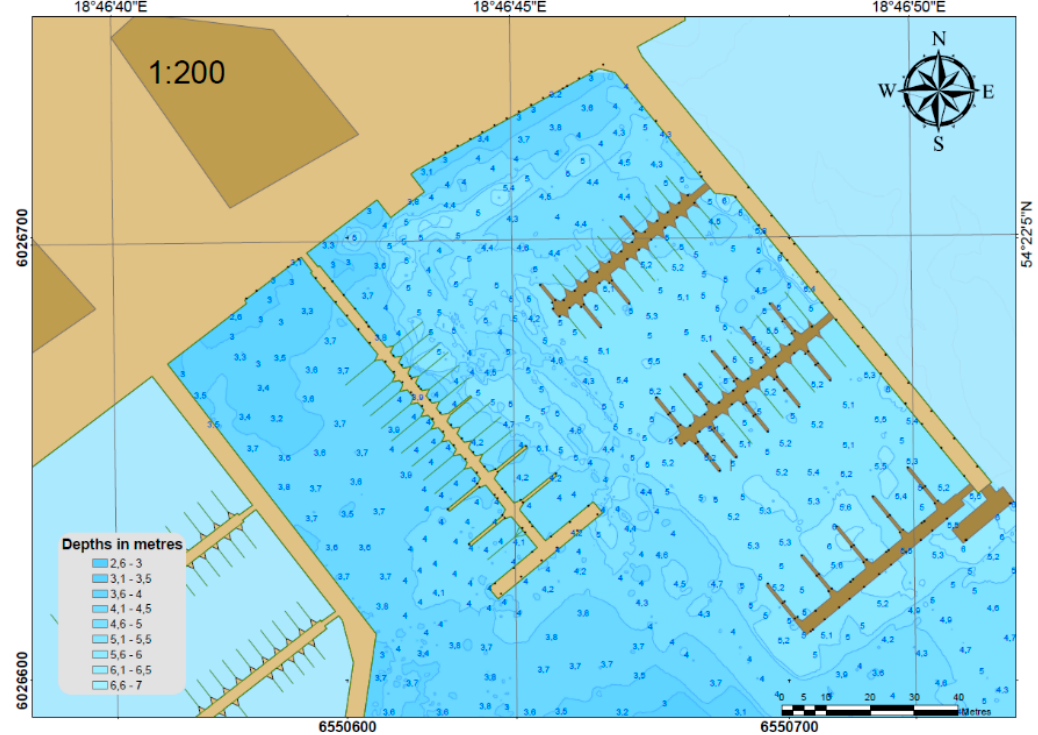
Figure 11. Bathymetric chart of the National Sailing Centre at the Gda ń sk University of Physical Education and Sport (NSC-GUPES).